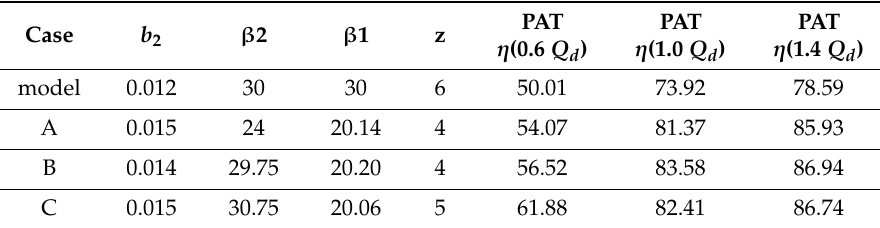
Table 14. Comparison of baseline model and the three optimized